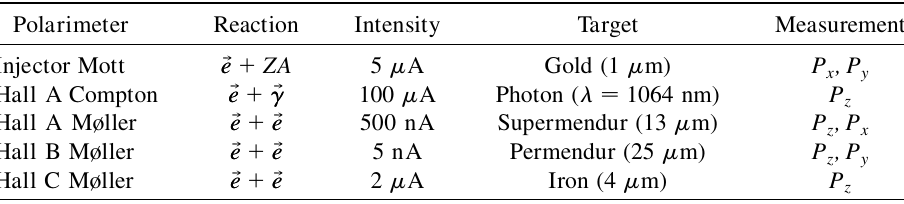
TABLE I. Operating parameters of the five Jefferson Laboratory electron polarimeters.